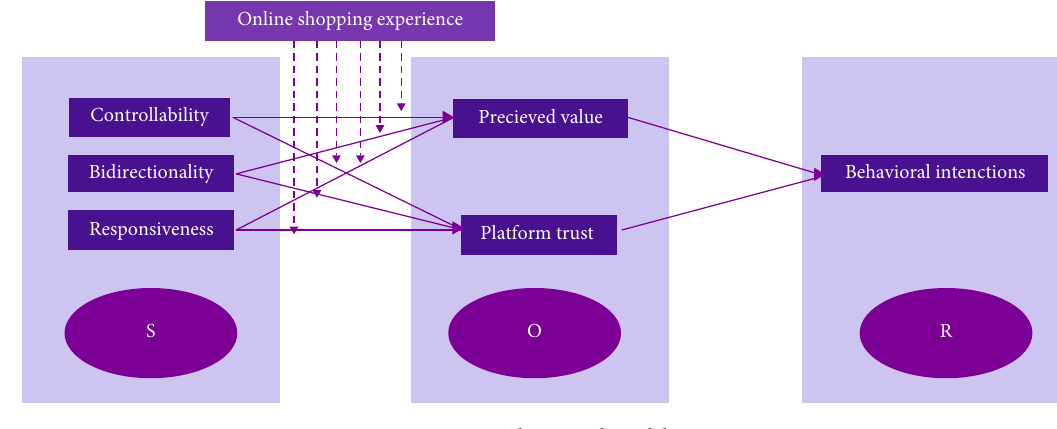
Figure 2: Theoretical